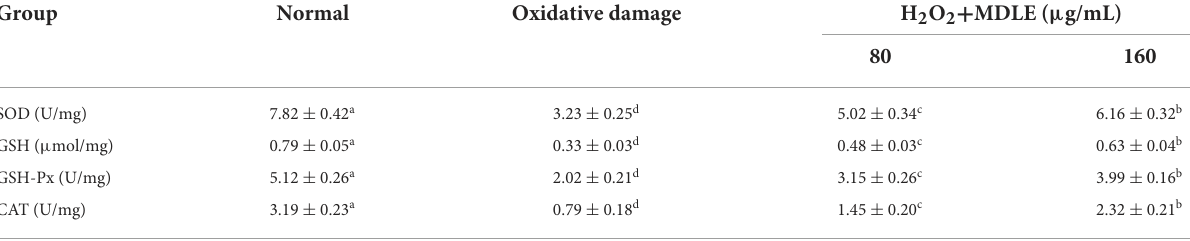
TABLE 3 SOD, GSH, GSH-Px, and CAT contents of Malus doumeri leaf extract (MDLE) treatment on H 2 O 2 induced oxidative damage of H9C2 cells. Group